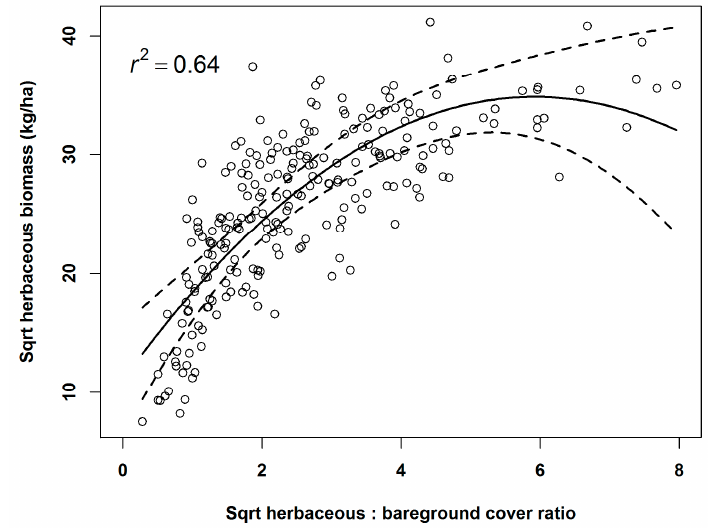
Figure 6. Scatter plot of the square root transformed fine-fuel biomass from plots and ratio of herbaceous to bare ground cover from plot data with a curvilinear fit (solid line) and 95th percentile confidence intervals (dashed lines).